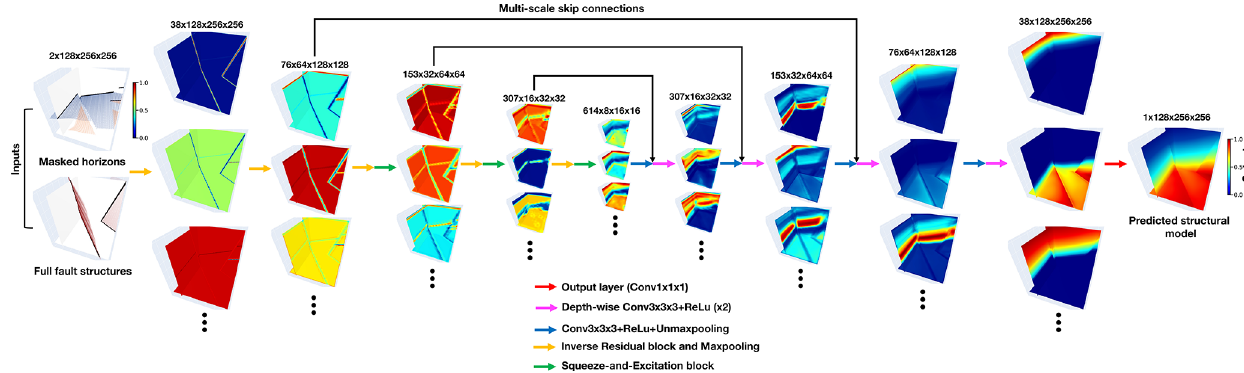
Figure 3. The normalized hidden feature representations computed in each spatial scale of the 3-D structural modeling